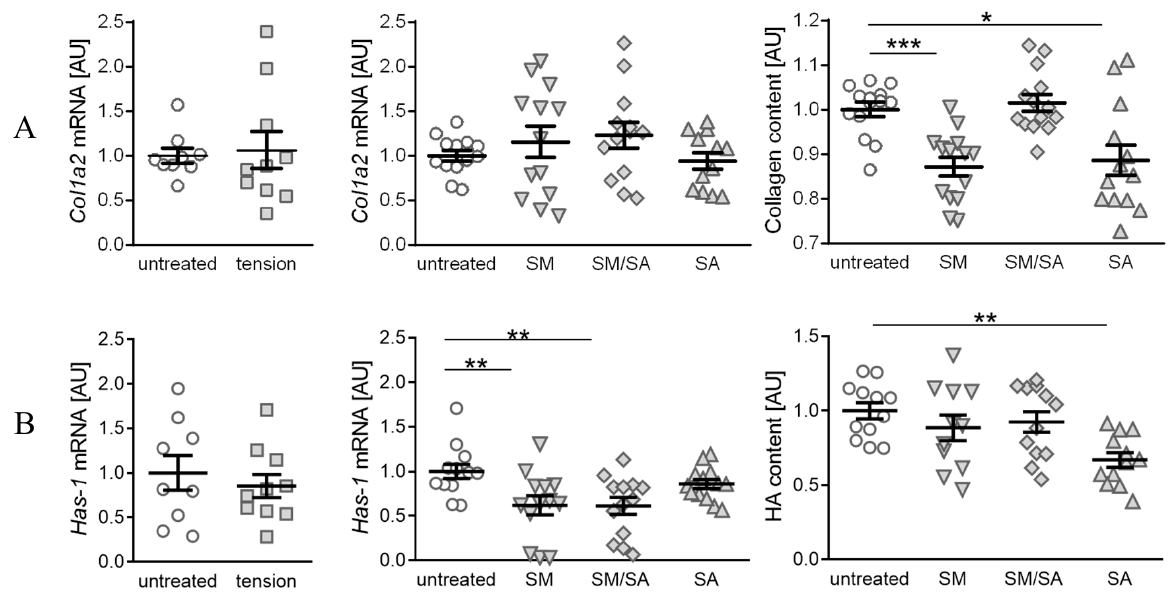
Figure 6. Synovial-fibroblast-mediated expression of matrix constituent products induced by various tensile loading protocols. Analysis of the gene expression profile of Col1a2 and soluble collagen components ( A ), and the gene expression of Has-1 and soluble glycosaminoglycan hyaluronan acid deposition ( B ) induced by the short high-frequency tensile strain or prolonged tensile strain, respectively. AU: Arbitrary units; SM: Moderate; SM/SA: Intermediate; SA: Advanced. n ≥ 6, * p ≤ 0.05, ** p ≤ 0.001, *** p ≤ 0.0001.